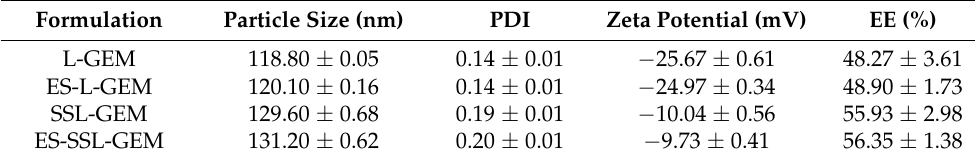
Table 1. Particle size, PDI, zeta potential, and EE of GEM liposome formulations (n = 3).